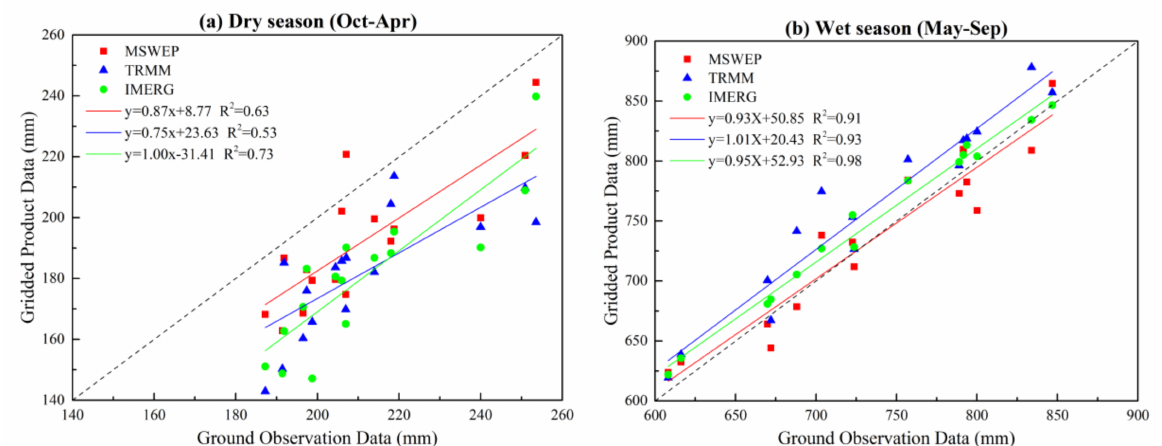
Figure 10. Seasonal distributions of precipitation (( a ) Dry season: October to April; ( b ) Wet season: May to September) across the study area from MSWEP, TRMM, and IMERG products as compared to CMA gauge